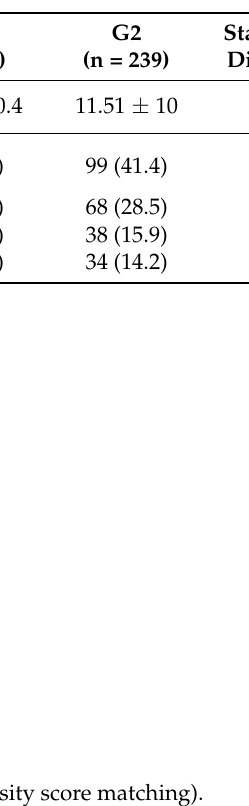
Table 1. Matched sample characterisation regarding ISS.